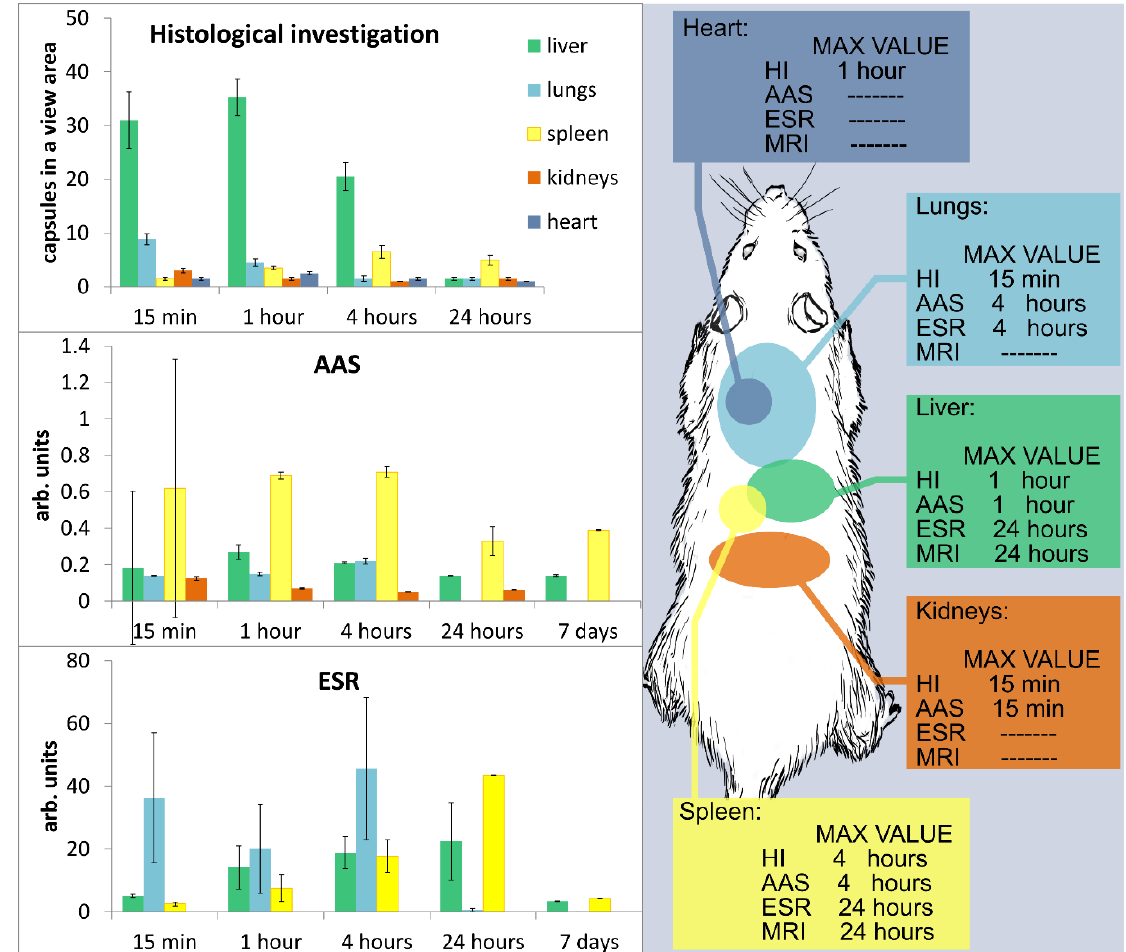
Figure 5. Biodistribution of magnetic microcapsules at intravenous injections. Left side: Microcapsule biodistribution data obtained by histological investigation, atomic absorption spectrometry (AAS) and electron spin resonance (ESR). Right side: maximum accumulation of microcapsules and MR signal for each organ observed.